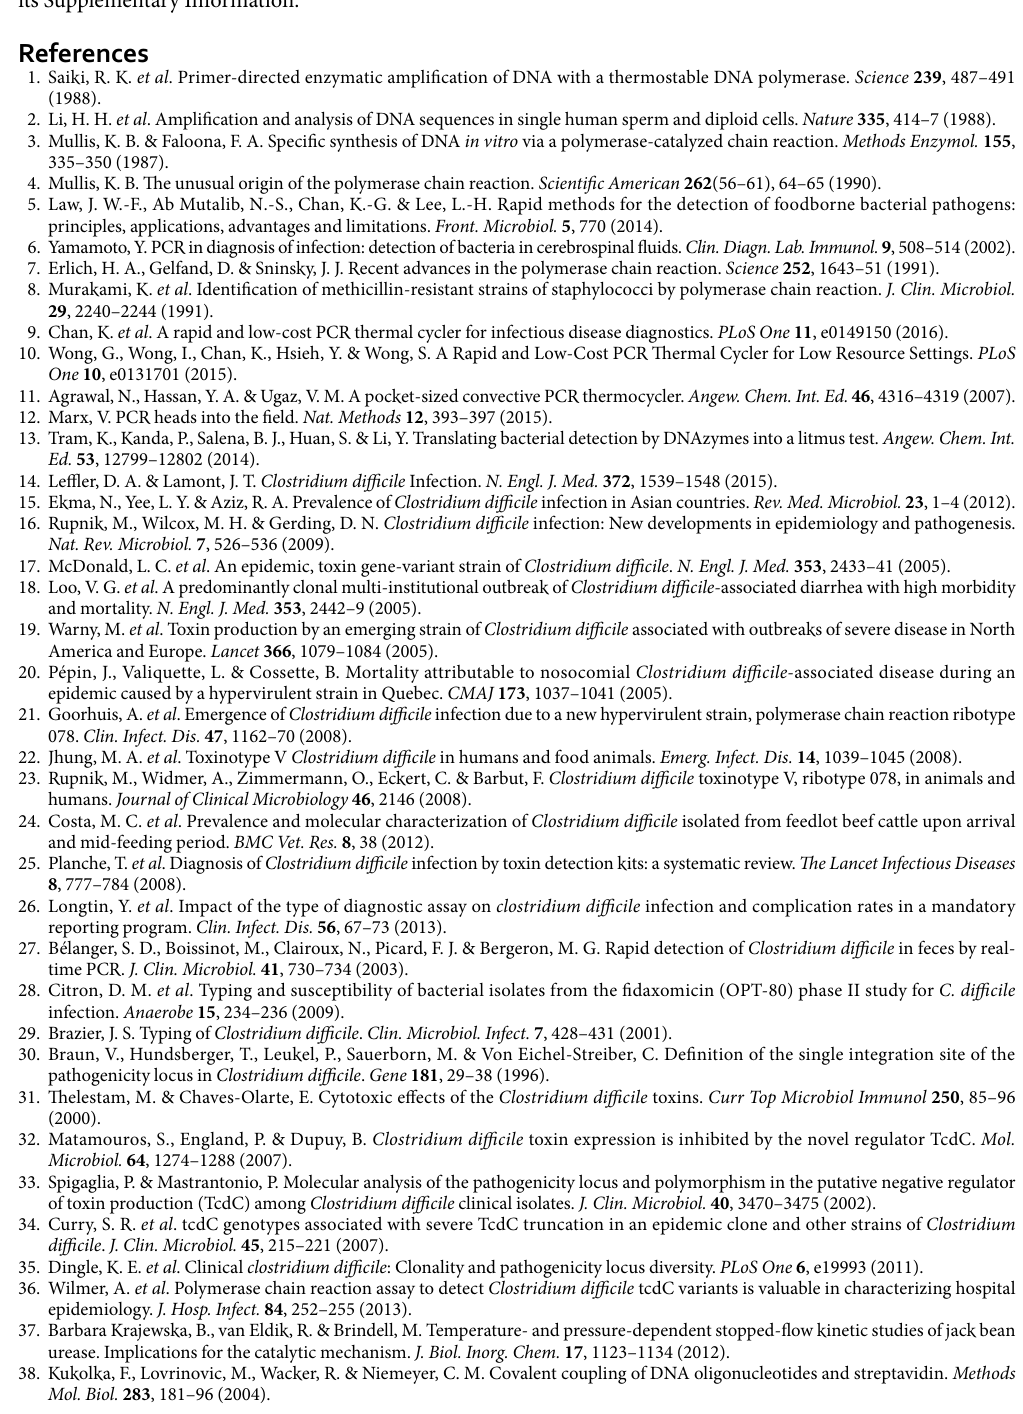
Stool sample test. Stool samples from 5 healthy donors and 12 patients infected by C. difficile were obtained from St. Joseph’s Healthcare-Hamilton, with informed consent from all the healthy donors and infected patients. The experimental protocols were approved by Hamilton Integrated Research Ethics Board (HiREB), McMaster University (Hamilton, Ontario, Canada). The methods were carried out in accordance with the relevant guide- lines and regulations. The three spiked samples were also prepared by adding ~2 × 10 7 C. difficile cells (ATCC 1870, ATCC1871 or ATCC1875) into 200 mg of stool sample from healthy donors. A Powerfecal DNA isolate kit (MO BIO LABORATORIES, USA) was used to extract total DNA from stool samples, and 100 ng of total DNA from each sample was used as template DNA for PCR-litmus test. The DNA was amplified using the following thermocycling steps: 94 °C for 5 min; 30 cycles of 94 °C for 1 min, 60 °C for 1 min and 72 °C for 1 min; 72 °C for 3